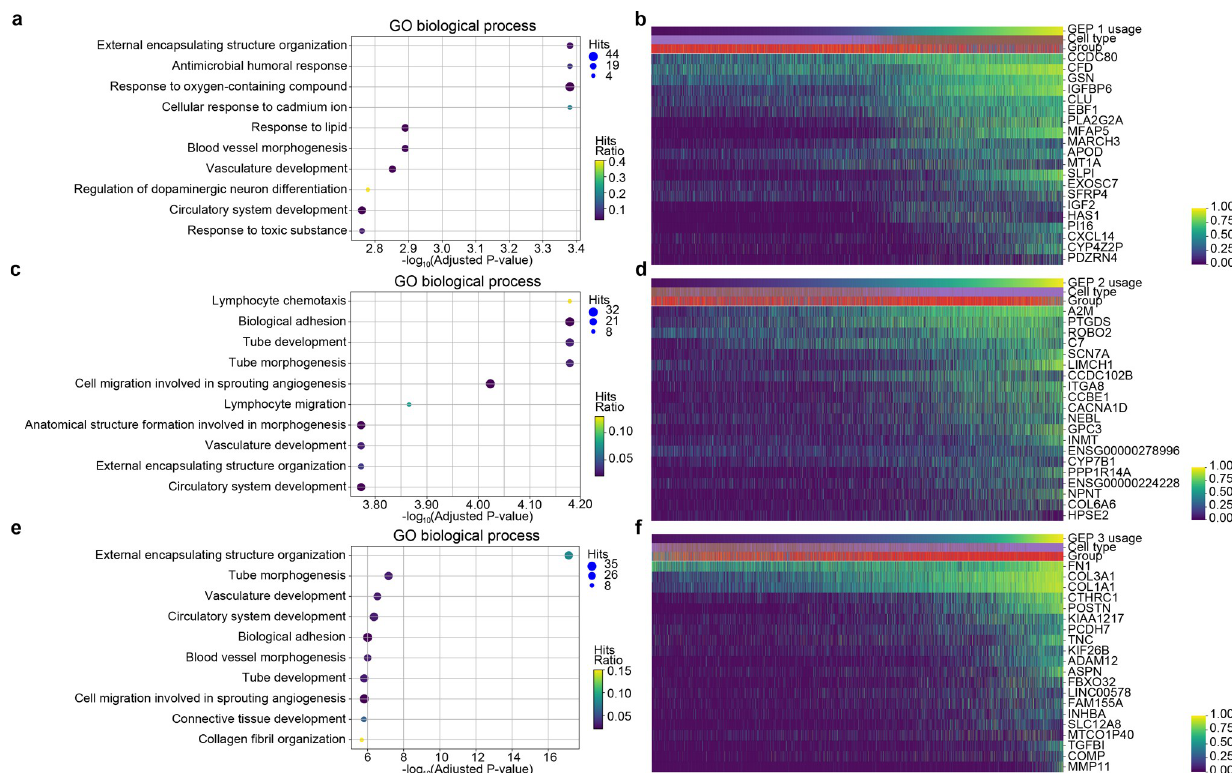
Fig 8. Enriched GO terms and top DEGs of GEPs in the lung fibroblast and myofibroblast cells. (a) The top 10 enriched GO terms using upregulated DEGs in GEP 1. (b) The expression levels of the top 20 DEGs of GEP 1 covaried with the inferred usage of GEP 1. (c) The top 10 enriched GO terms using upregulated DEGs in GEP 2. (d) The expression levels of the top 20 DEGs of GEP 2 covaried with the inferred usage of GEP 2. (e) The op 10 enriched GO terms using upregulated DEGs in GEP 3. (f) The expression levels of the top 20 DEGs of GEP 3 covaried with the inferred usage of GEP 3. Top 20 genes in b, d and f were selected based on their z-scores. Cells in b, d and f were sorted by increasing order of the inferred cell usage of GEP 1, GEP 2 and GEP 3, respectively. Colors of cell types and disease groups in b, d and f are coded in the same way as colors in Fig 7a and 7b, respectively.